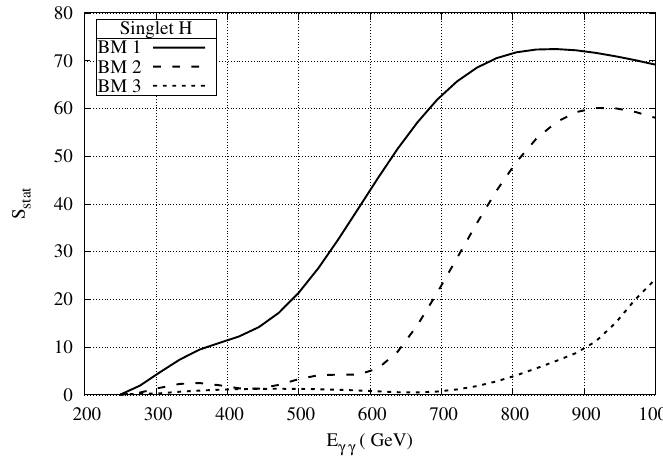
Figure 10 . Statistical Sensitivity as a function of γγ collider energy for the process γγ → hh for BM1, BM2 and BM3 (as given in table 5) in the model with an additional heavy singlet Scalar H